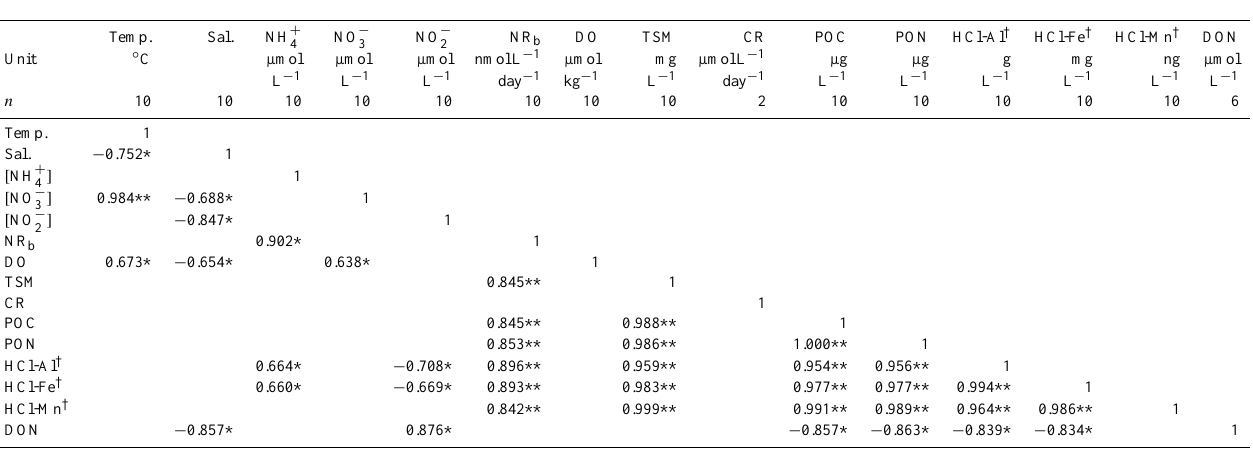
n is sample number. The other numbers are the Pearson’s correlation coefficient of two by two parameters. * indicates p < 0 . 05 and ** indicates p < 0 . 01 . † HCl-Al, HCl-Fe and HCl-Mn respectively indicate reactive Al, reactive Fe and reactive Mn which were extracted from suspended particles by 1NHCl. The method is described in Sect. 2.2. Table 2b. Correlation matrix of field-surveyed data in the inner plume of the Chang Jiang River plume. Temp.